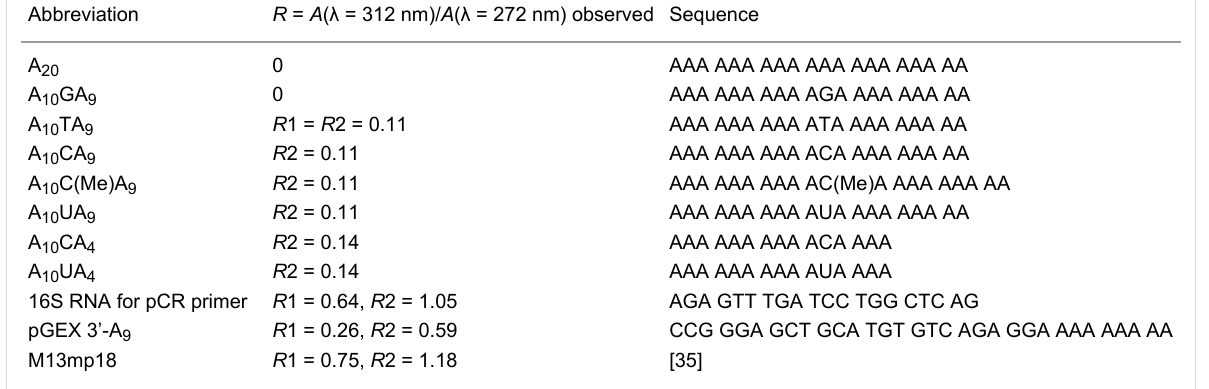
Table 1: List of oligos/DNA tested in this study with abbreviations and sequences; all bases deoxy including deoxyuridine (U). R 1 and R 2 represent the ratio R value upon using protocol A or B, respectively (see Experimental). Abbreviation